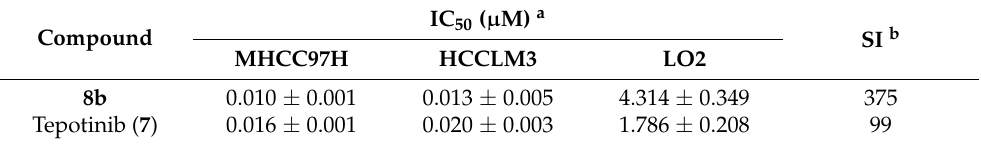
Table 2. In vitro antiproliferative activity of compound 8b against MHCC97H, HCCLM3 and LO2 cell